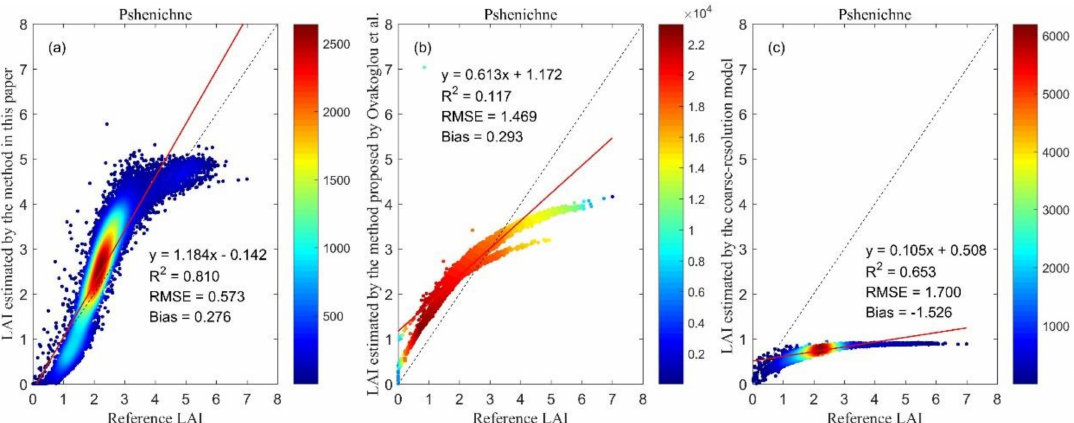
Figure 10. Scattering density map between the estimated LAI map and the reference LAI map at the Pshenichne site. ( a ) Based on the model-downscaling method proposed in this paper; ( b ) based on Ovakoglou’s downscaling method; ( c ) based on the model F ( P ) .